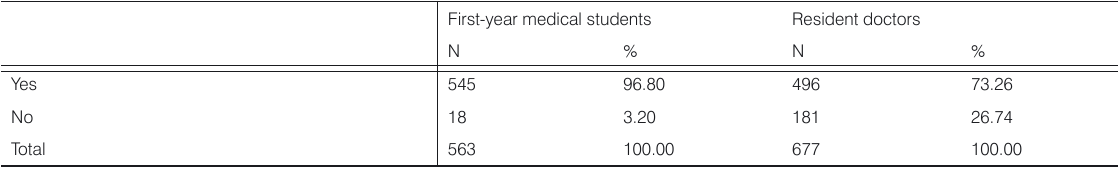
Table 4. Would you choose the medical profession